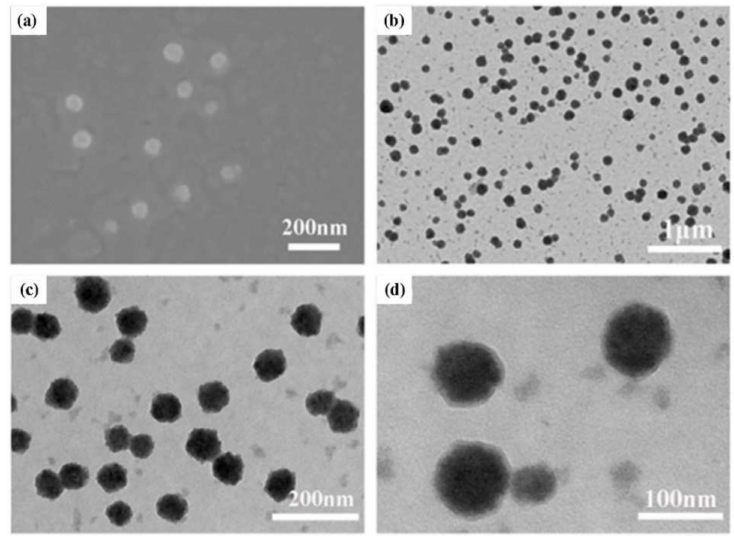
Figure 2. Characterization of (CP) 6 NS. ( a ) Scanning electron microscopy image of (CP) 6 NS. ( b – d ) TEM image of (CP) 6 NS.